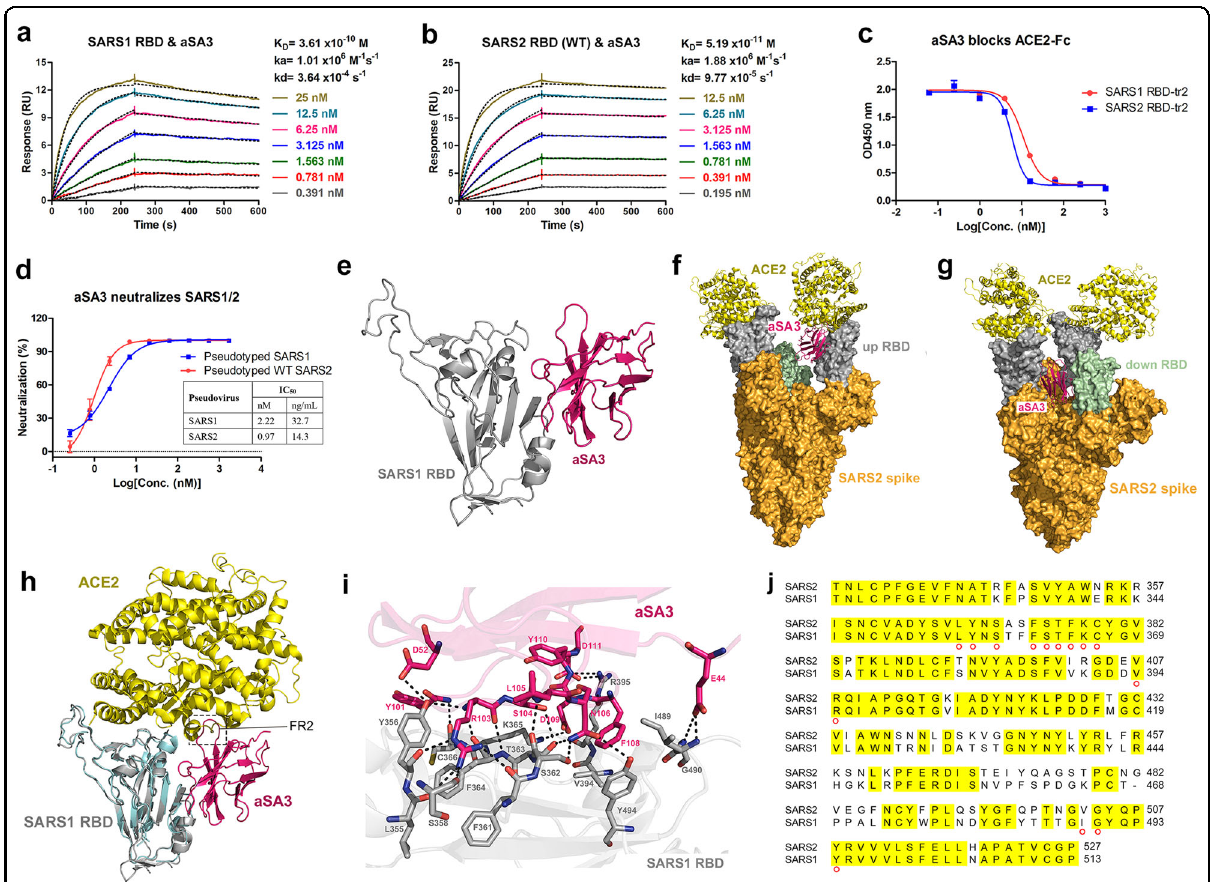
Fig. 1 aSA3 cross-reacts with SARS1 and WT SARS2 by targeting an epitope on RBD core. a , b The binding kinetics of aSA3 to SARS1 RBD ( a ) and WT SARS2 RBD ( b ) were monitored by the Biacore 8K system. The actual responses (colored lines) and the data fi tted to a 1:1 binding model (black dotted lines) are shown. K D , equilibrium dissociation constant; k a , association constant; k d , dissociation constant. c The blocking abilities of aSA3 against the interaction between ACE2-Fc and SARS1/2 RBD were tested by competitive ELISA. SARS1 RBD-tr2 or WT SARS2 RBD-tr2 were coated on the plate and incubated with a mixture of 20 nM ACE2-Fc with serial dilutions of aSA3. Bound ACE2-Fc was detected with HRP conjugated anti-IgG1 Fc antibody. Error bars indicate the means ± SD from two independent experiments. d The neutralizing activities of aSA3 against pseudotyped SARS1 and WT SARS2. The IC 50 values of the pseudovirus neutralization assay were calculated by fi tting the inhibition rates against antibody concentrations with a sigmoidal dose-response curve. Error bars indicate the means ± SD from triplicates. e The overall structure of aSA3 (hotpink) bound to SARS1 RBD (gray) using cartoon presentation. f , g Superposition analysis of aSA3 onto one “ up ” RBD ( f ) and one “ down ” RBD ( g ) in the cryo-EM structure of the trimeric spike of SARS2 (PDB: 7KMZ). h Structure alignment of the aSA3:SARS1 RBD complex with the ACE2:SARS1 RBD complex (PDB: 2AJF). The dotted box marks the region where FR2 of aSA3 clashes with ACE2. i Zoom-in view of the interaction interface of aSA3 and SARS1 RBD. Interacting residues are shown as sticks, and dotted lines indicate hydrogen bonds and salt bridges. j Sequence alignment of the SARS1 and SARS2 RBDs. Identical residues are marked with yellow shading, and residues interacting with aSA3 are indicated with red